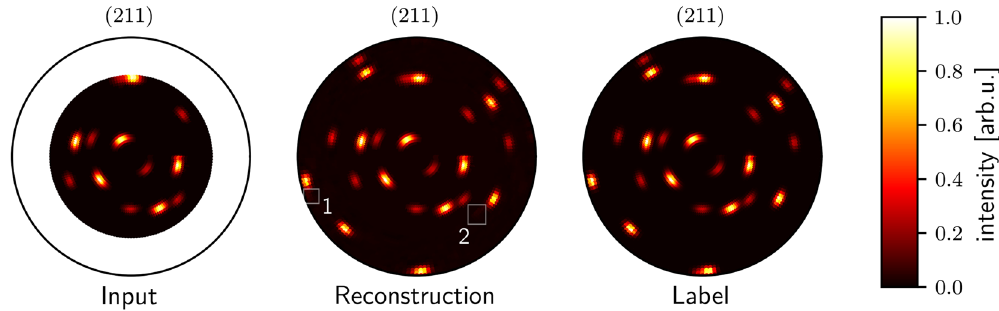
Figure 3. Reconstruction of missing tilt angle intensities for a 211 lattice plane pole plot with three visible grains. On the left, the simulated cropped input with ψ max = 60 ◦ is shown. The plot in the middle is the output of the reconstruction network. On the right is the entire label as output by the simulation. In the reconstruction plot, it is visible in the rectangle denoted with 1 that the reconstruction network overdraws a pole. In the area labeled with 2, the reconstruction slightly indicates some poles that do not exist in the label. Despite these artifacts, the overall reconstruction appears accurate. Furthermore, the background of the reconstruction appears to be slightly brighter compared to the label. All pole plots are min-max normalized.